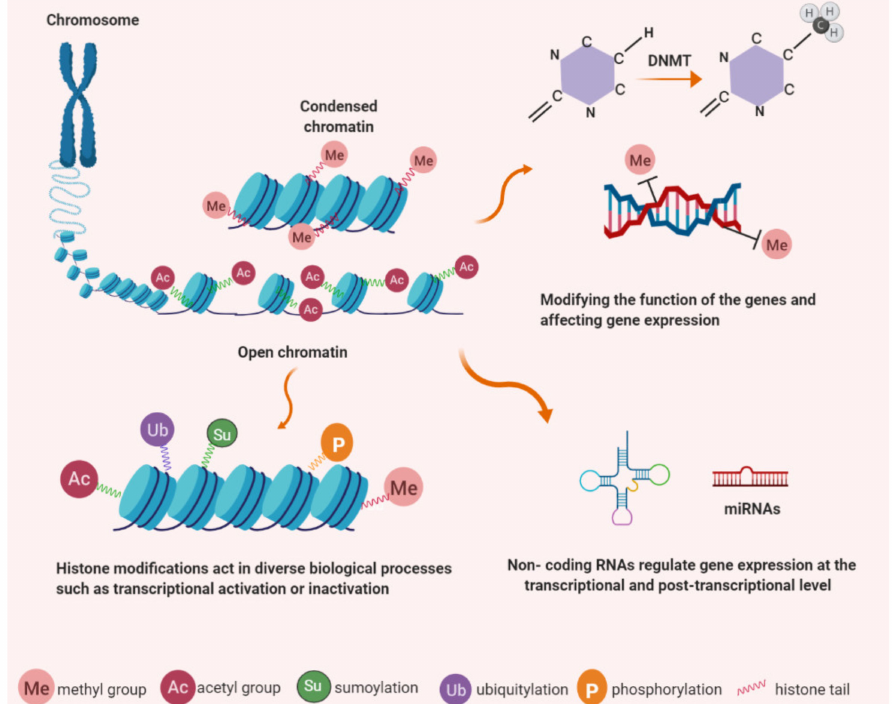
Figure 1. Epigenetic modifications have important roles in chromatin structure and gene expression. DNA is wrapped around histone proteins to form chromatin; less condensation associates with transcriptional activity while more condensed chromatin is found in a state of transcriptional silencing. Epigenetic mechanisms occur as covalent modifications of either DNA or histone proteins. DNA methylation (e.g. cytosine methylation and hydroxymethylation) and histone modification, (e.g. acetylation, methylation, phosphorylation, ubiquitination and sumoylation). Non-coding RNAs regulate protein-coding genes and associate with DNA methylation and histone